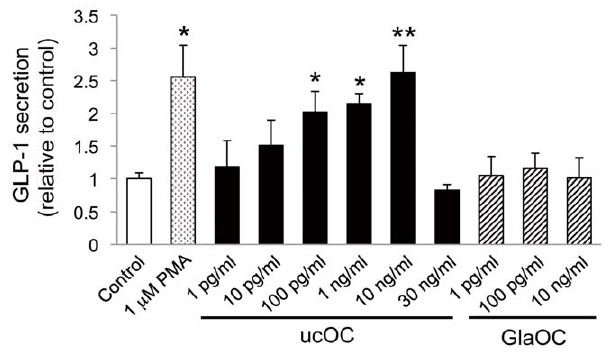
Figure 2. OC-induced GLP-1 secretion in STC-1 cells. STC-1 cells were incubated for 60 min with vehicle (control) or the indicated concentrations of ucOC, GlaOC, or PMA. Data are expressed relative to the control value (33.1 pg per 1 6 10 5 cells) and are means 6 SEM from four to eight independent experiments. * P , 0.05, ** P , 0.01 versus control (Student’s t test).